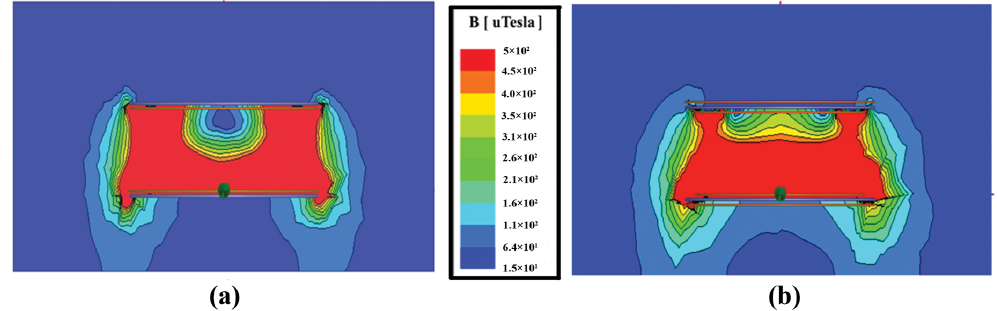
Figure 18. The EMF level for the two proposed designs observed on ( a ) z -axis points and ( b ) x -axis points.